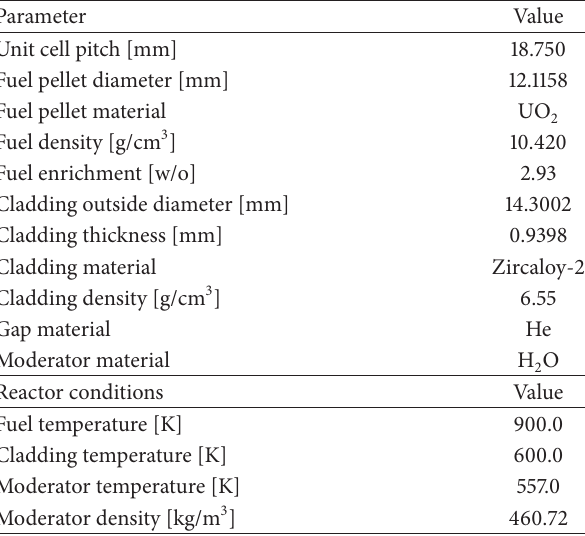
Table 2: BWR lattice